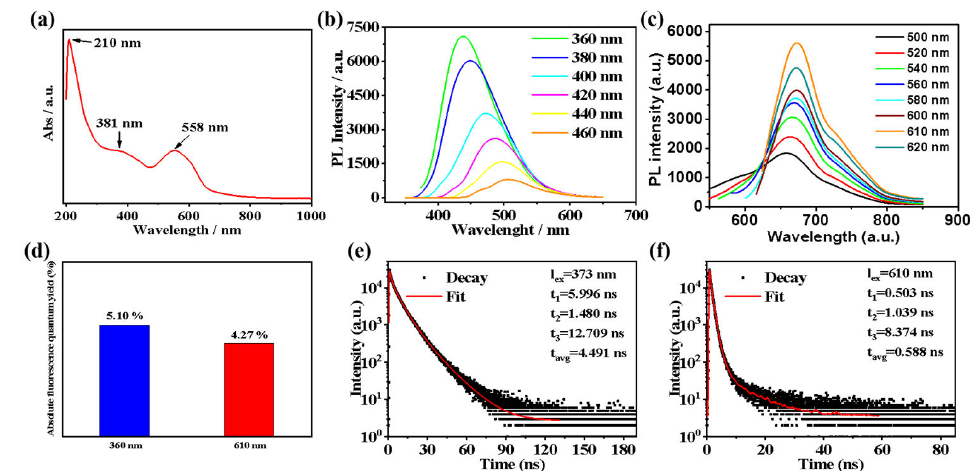
Figure 3. ( a ) UV − vis absorption and PL spectra under ( b ) 360–460 nm and ( c ) 500–620 nm excitation wavelengths of T − CDs in water. ( d ) Absolute fluorescence quantum yield of T − CD s in H 2 O under 360 nm and 610 nm excitations; Lifetime decay profiles of T − CDs in H 2 O under ( e ) 360 nm and ( f ) 610 nm excitations.